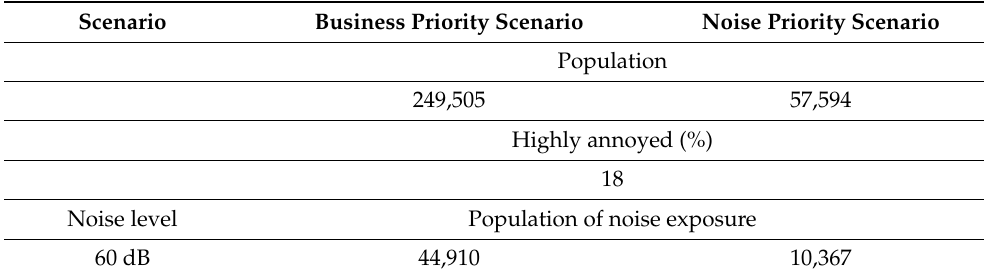
Table 11. Size of population exposed to high levels of noise by scenarios.